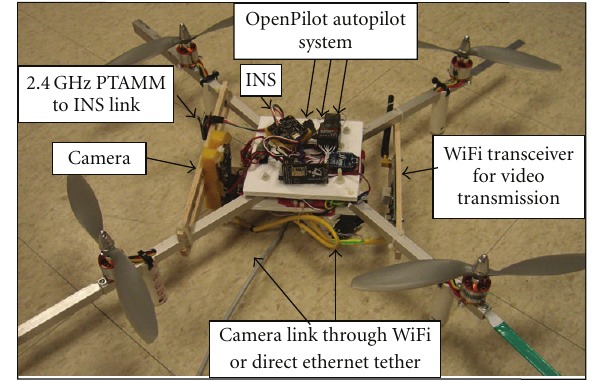
Figure 7: Multirotor airframe modified for PTAMM.